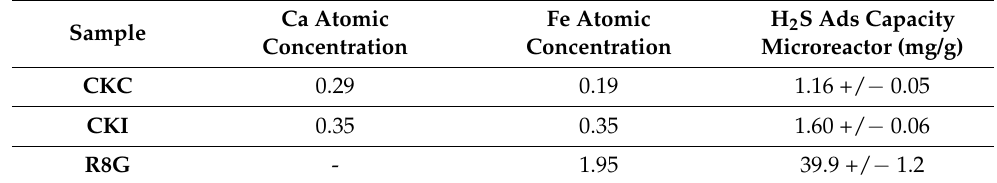
Table 4. Atomic concentration percentages and microreactor data.